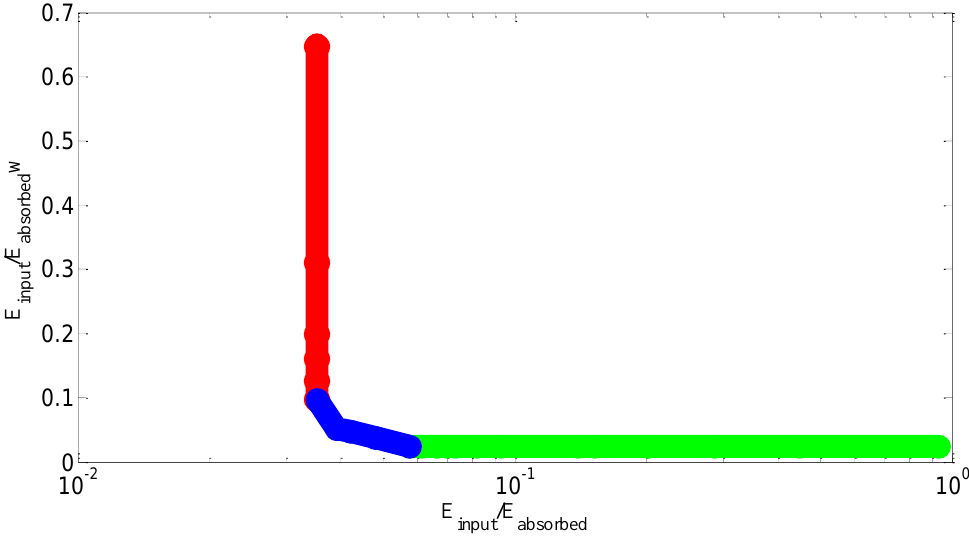
Fig. 10. Pressure impulse curve for SDOF system subjected to blast load on rear